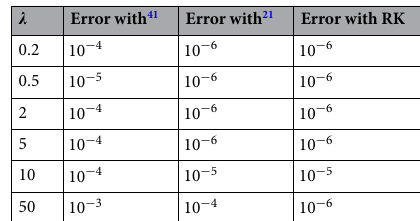
F ′′ ( 0 ) achieved by means of modified Chebyshev wavelets − =